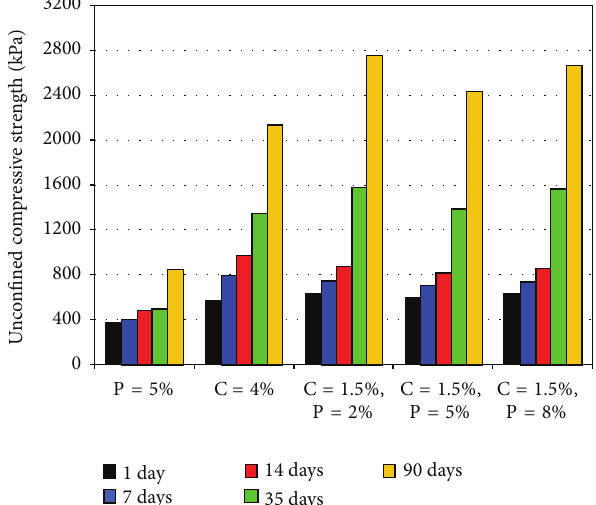
Figure 10: Comparison of results from unconfined compressive strength